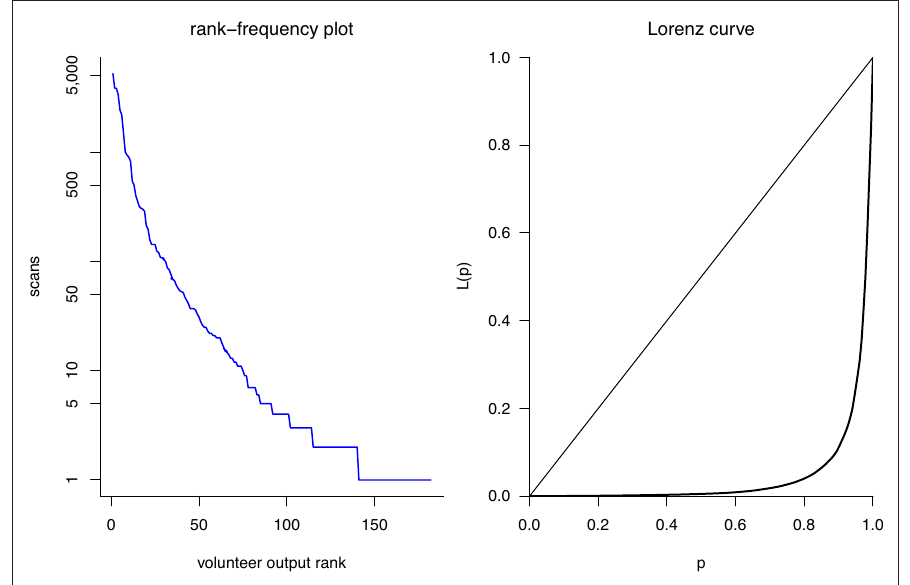
Figure 5: Number of scans entered per volunteers (left panel) and Lorenz curve (Gini: 0.91) (right panel). The Lorenz curve traces the cumulative percentage of scans entered (L(p)) against the cumulative percentage of volunteers, ordered by number of entered scans (p). Table 5: Outreach events of the “Yes, I